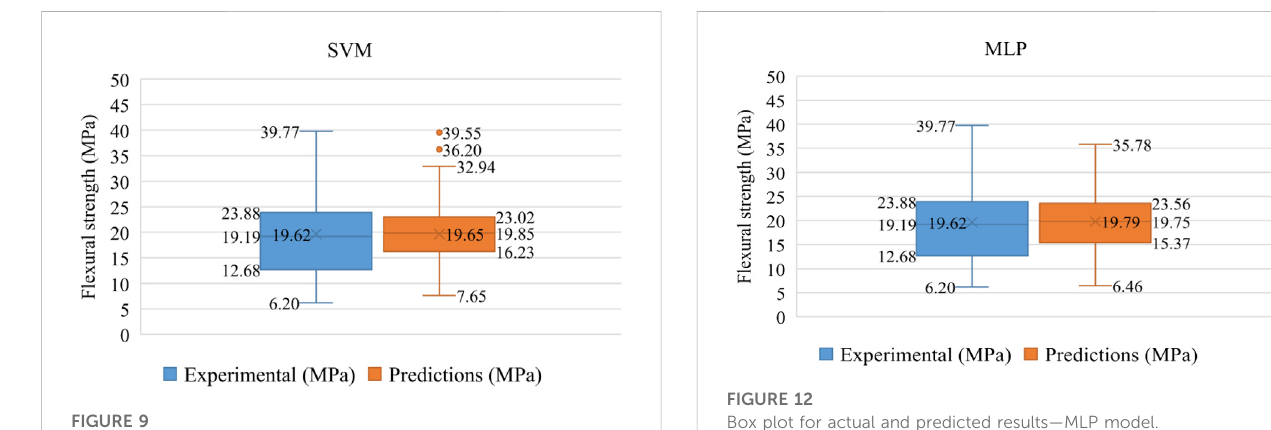
FIGURE 9 Box plot for actual and predicted results — SVM model.